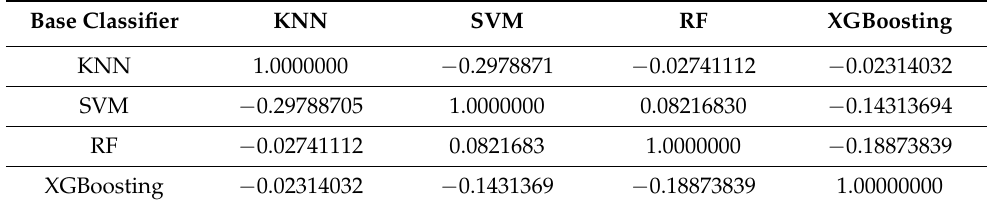
Table 3. Correlation among selected base classifier models.